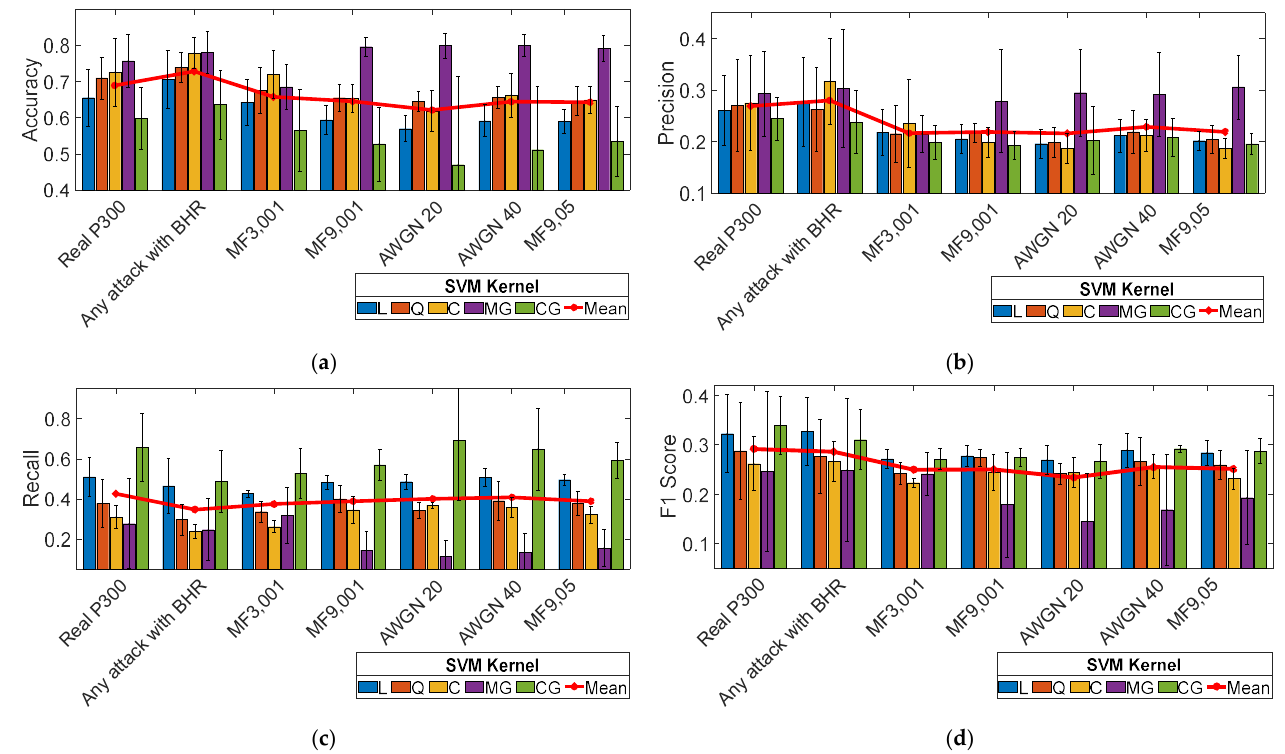
Figure 6. Test of the SVM models using the real P300 dataset (real P300) vs. hacked datasets. Performance metrics are ( a ) accuracy, ( b ) precision, ( c ) recall, and ( d ) F1-score. Data are presented as averages and standard deviations over the five subjects. The black line with markers reports the average value of the metric calculated on the five SVM kernels.